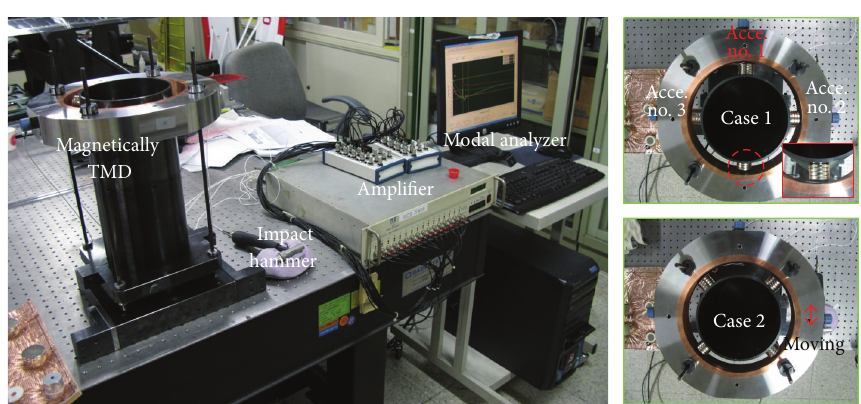
Figure 15: Experimental setup of mTMD and arrangements of